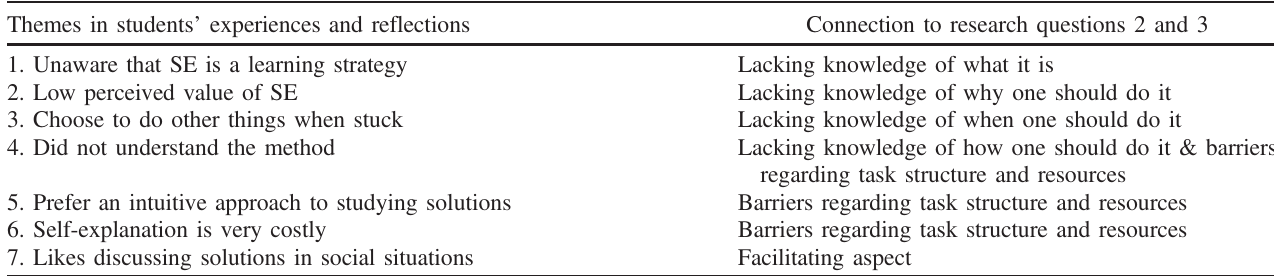
TABLE III. Themes from students ’ experiences and reflections on self-explanation (SE). Themes in students ’ experiences and